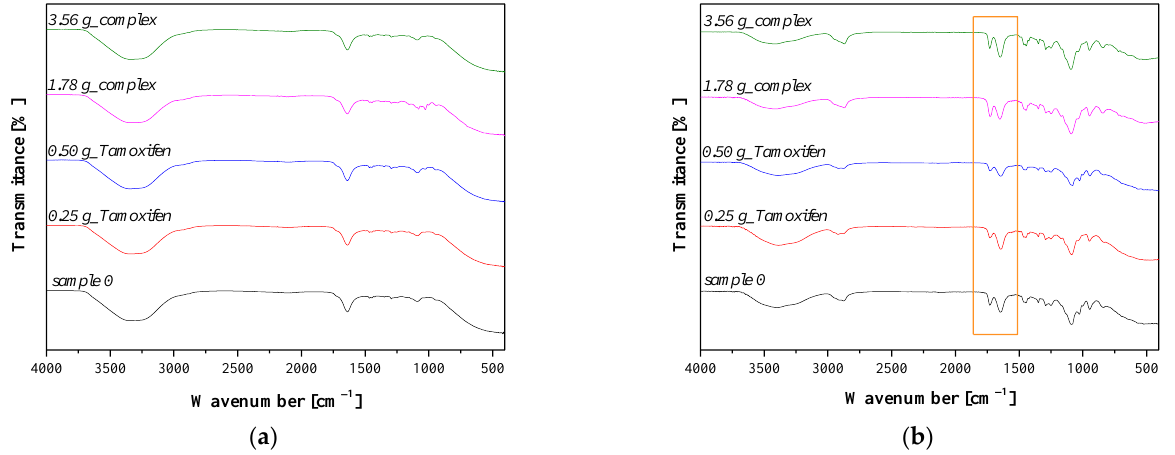
Figure 6. FT-IR spectra of hydrogels directly after their synthesis ( a ) and after 24 h of drying ( b